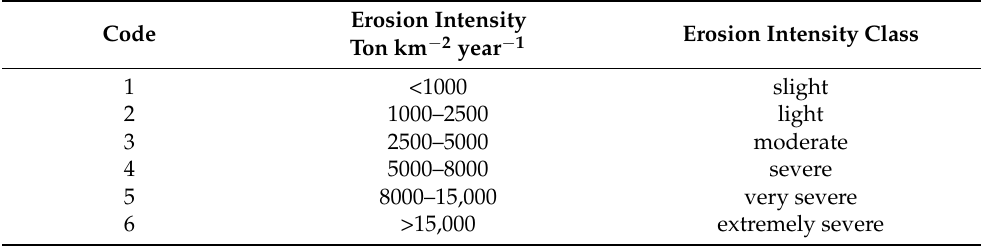
Table 2. The soil erosion classification index based on the standards for the classification and gradation of soil erosion SL190-2007 issued by the Ministry of Water Resources of